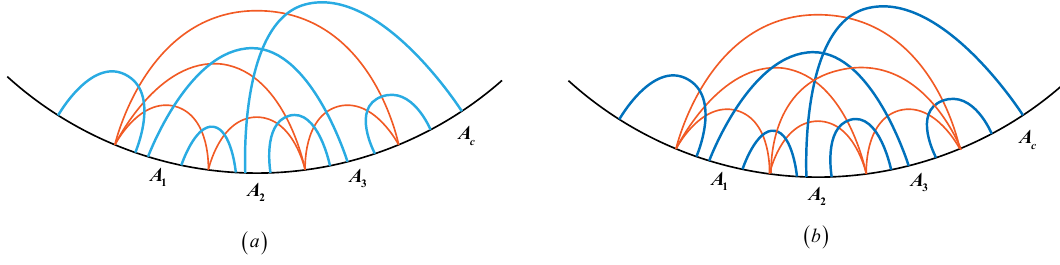
Figure 2 . Two kinds of multiflows in realizing the locking thread configuration characterizing the entanglement between a tripartite subregion A and its complement A c : (a) in the scheme by theorem 2, the locking thread configuration is described by a ν v multiflow, which can only lock five RT surfaces; (b) in the scheme by theorem 3, the locking thread configuration is described by a ν a multiflow, which can lock six RT surfaces. We draw the latter multiflow in deep blue to distinguish